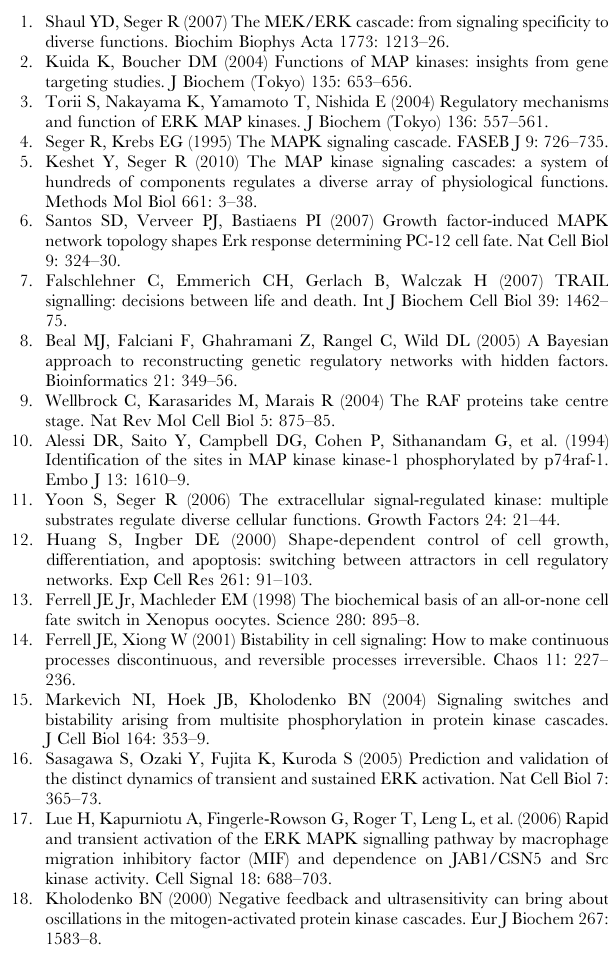
List S2 The mathematical equations of the generic MAPK cascade model for simulation.